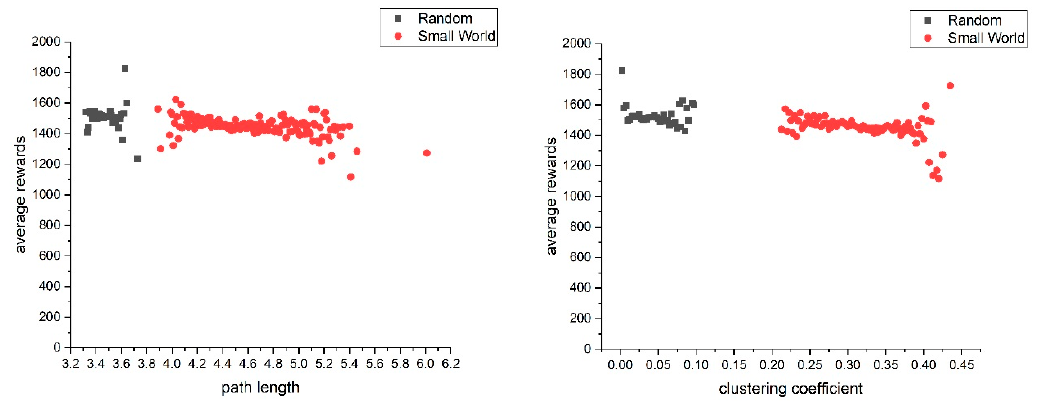
Figure 6. Average rewards of firms for different path-length and clustering coefficients after 500 simulation steps.